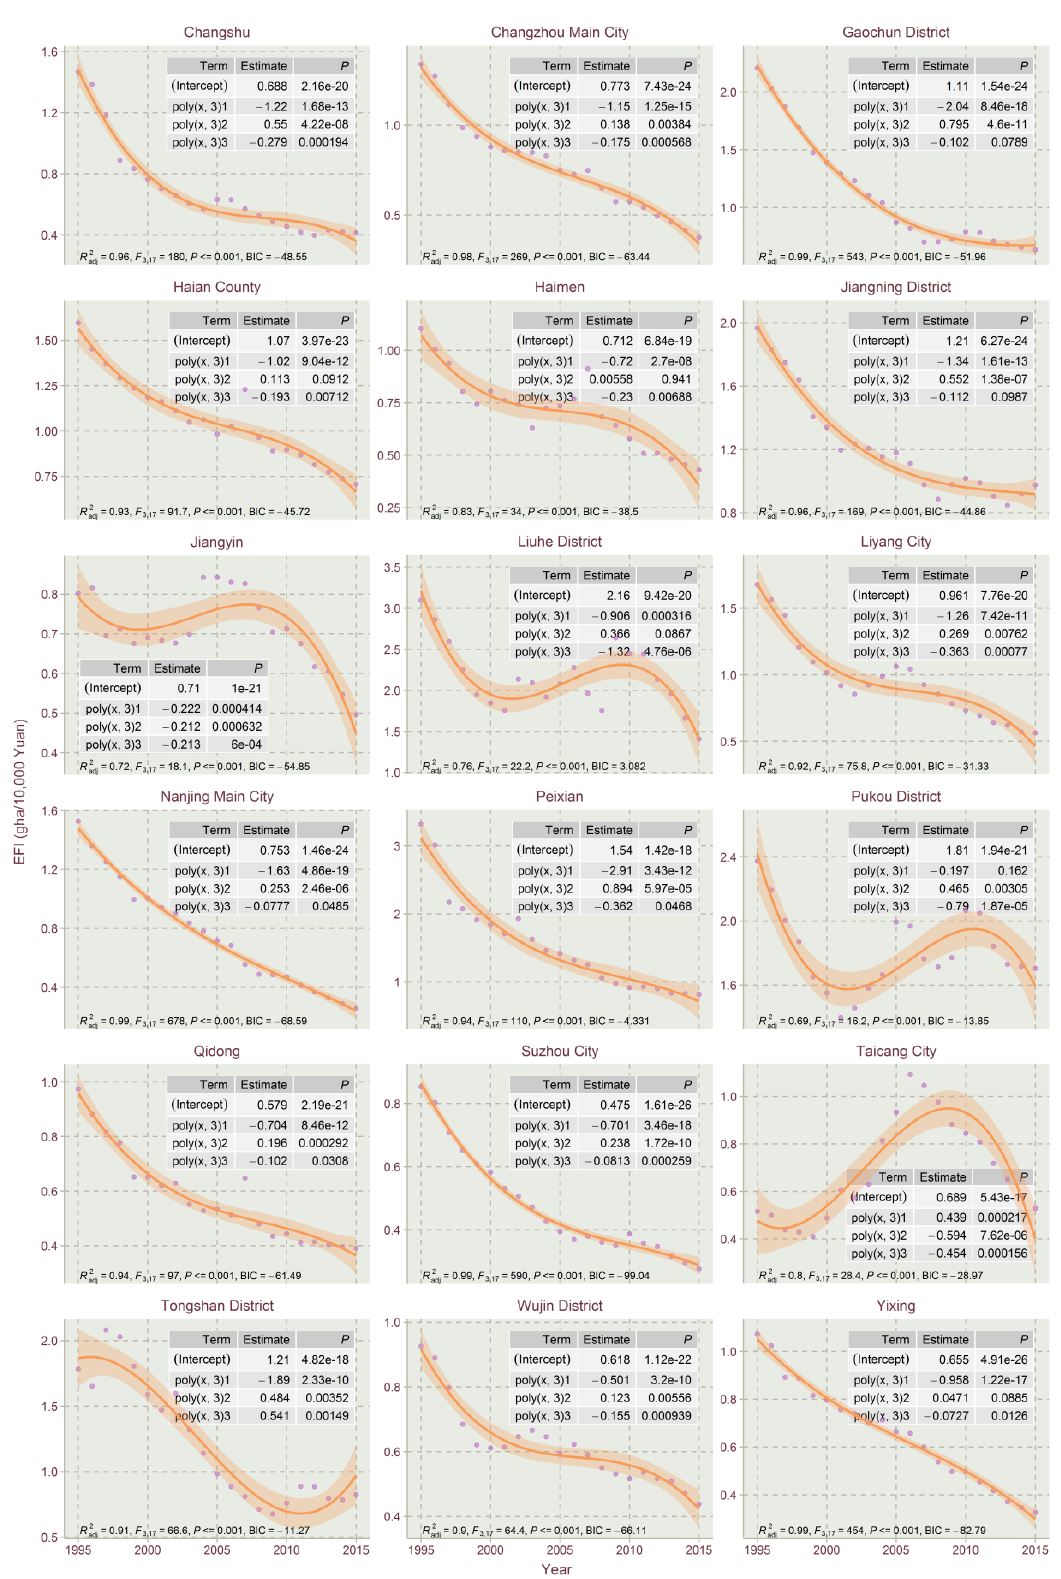
Figure 7. Cubic orthogonal curve fitting of EFIs of Jiangsu Province for 1995–2015 (Part 1).